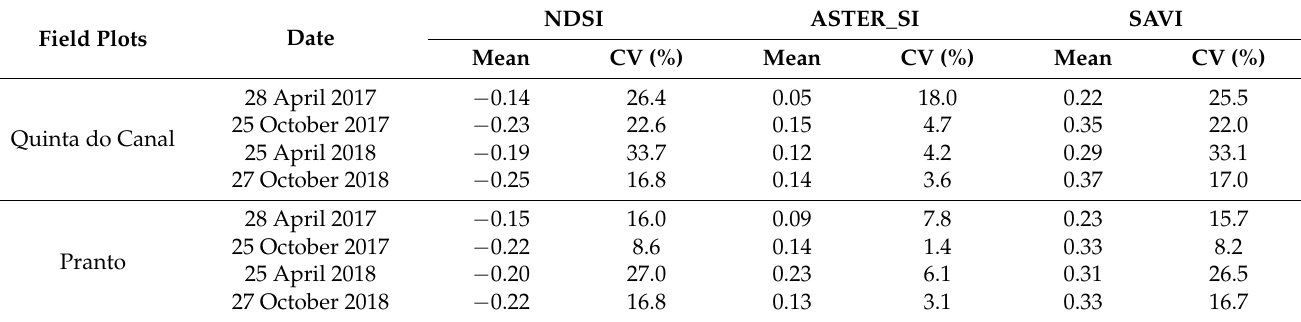
Table 6. NDSI, ASTER_SI and SAVI for the selected rice field plots of Quinta do Canal and Pranto: mean and coefficient of variation (CV) for specific dates in Spring and Autumn that illustrate the conditions before and after the rice cultivation period in 2017 and